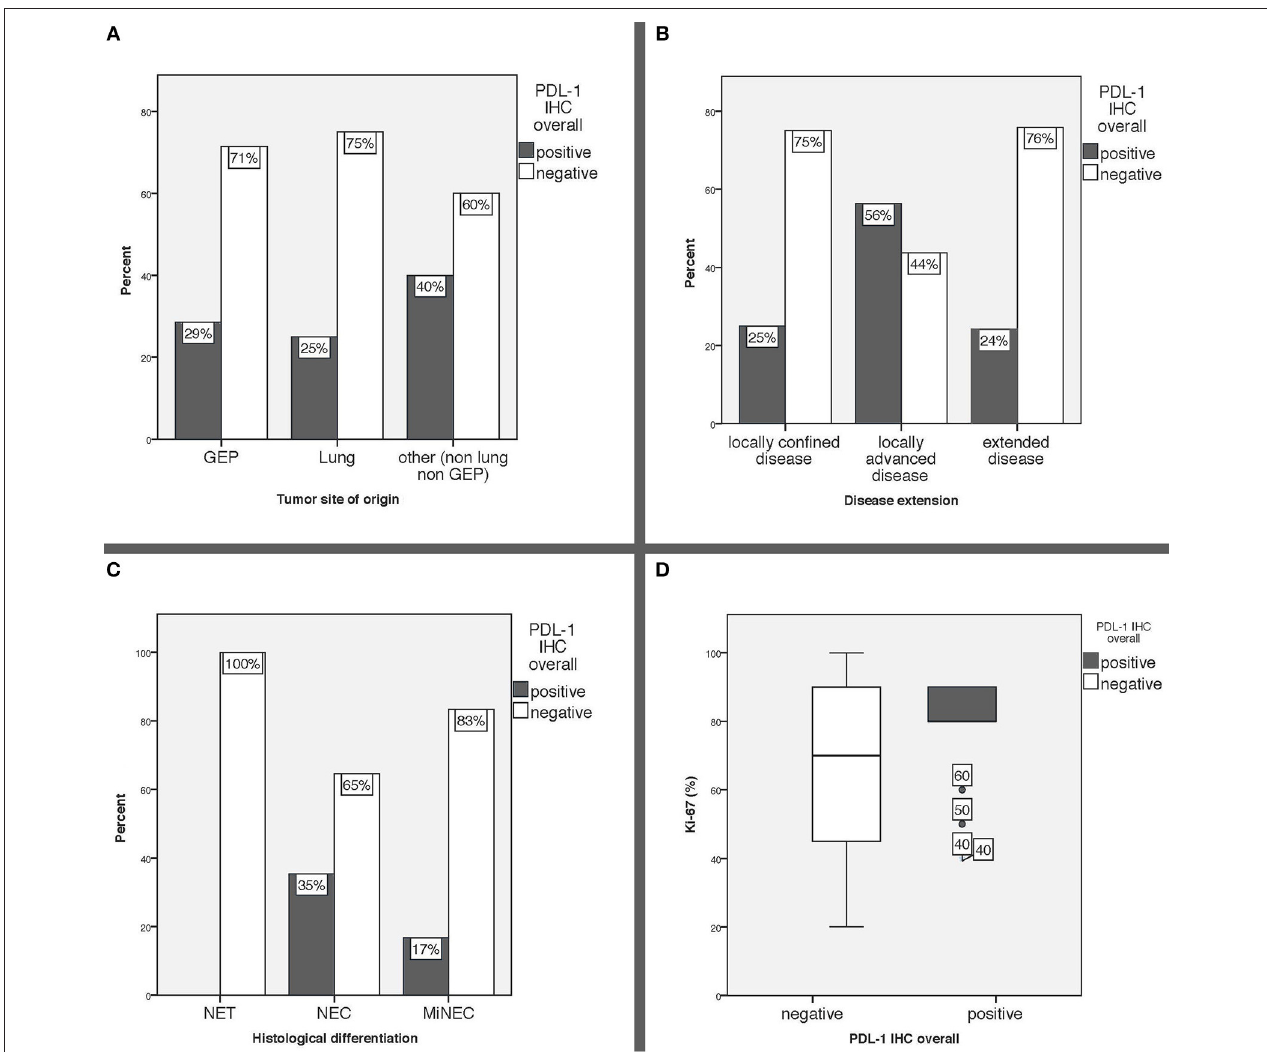
FIGURE 2 | (A) PD-L1 expression overall in relation to tumor site of origin, (B) PD-L1 expression overall in relation to disease extension, (C) PD-L1 expression overall in relation to histological differentiation, (D) Ki-67 index expressed in % according to PD-L1 status. GEP: gastro-entero-pancreatic, other: includes 8 tumors originated from the genitourinary system, 4 from the ear, nose and throat mucosa, 1 Merkel cell carcinoma and 7 cancers of unknown primary, IHC: